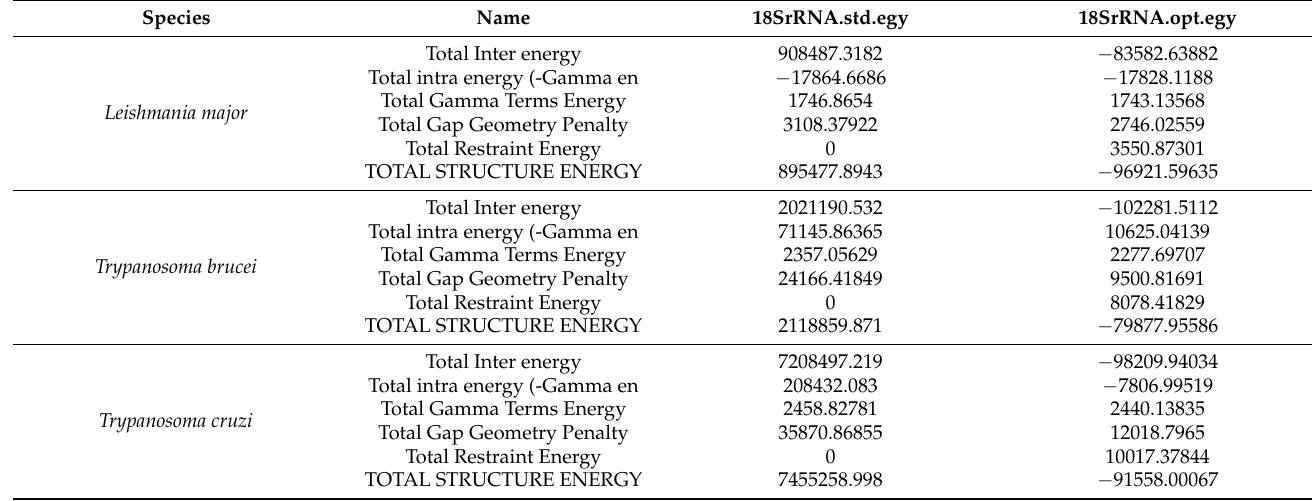
Table 2. 18S rRNA Energy Optimization Table obtained from results of RNA 123, which helps minimize the energy from a large positive figure to a more acceptable negative figure that is biologically functional.